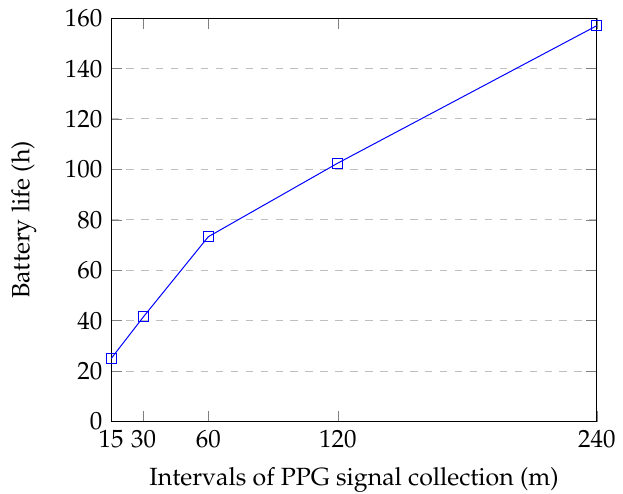
Figure 9. Battery life time of the watch for different intervals. Each interval contains 12 min of PPG signal